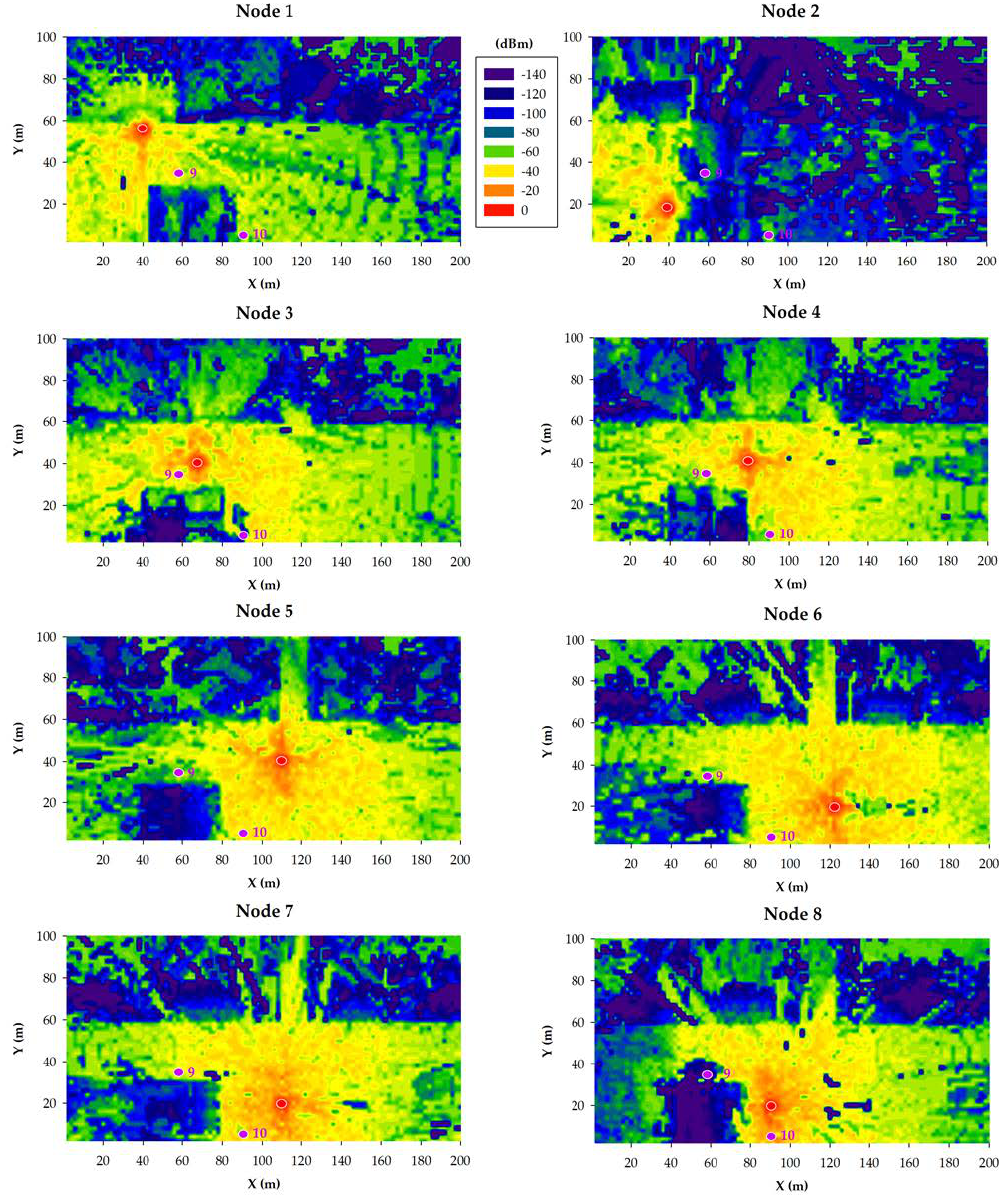
Figure 11. 868 MHz simulation results: RF power level distribution in a bi-dimensional plane on the ground